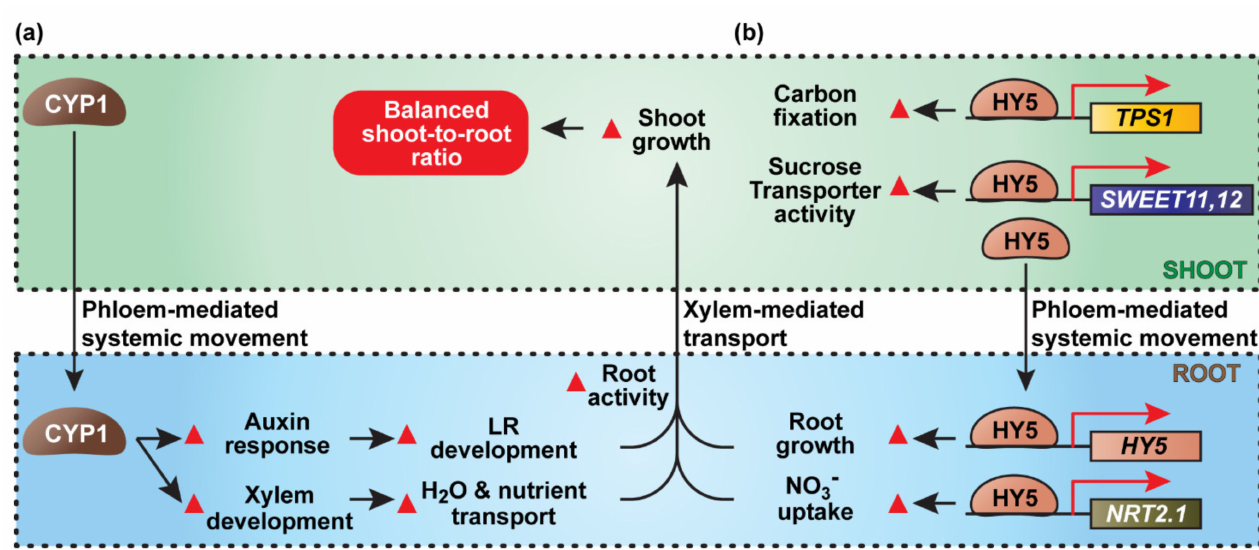
Figure 3. Light promotes root growth and nutrient absorption. ( a ) CYP1 is a phloem mobile protein that regulates shoot-to-root homeostasis. Light intensity determines the expression level of CYP1 in source leaves. Shoot-derived CYP1 protein accumulates in the roots, leading to activation of the auxin responses, thereby enhancing lateral root formation. Phloem-mediated systemic regulation, through this CYP1 pathway, is also involved in xylem development, which is critical for transport of H 2 O and mineral nutrients from roots to shoots. ( b ) Arabidopsis ELONGATED HYPOCOTYL5 (HY5), a key positive regulator of light signaling, is a phloem mobile transcription factor that traffics from shoot to root. In the aboveground tissue, HY5 binds to the promoters of TPS1, SWEET11, and SWEET12 to regulate carbon fixation and phloem-mediated transport of photoassimilates. Mobile HY5, derived from shoots, binds the promoter regions of HY5 and NRT2.1 genes in the root to promote root growth and nitrate uptake. Both shoot-derived CYP1 and HY5 can lead to enhanced root activity to improve shoot growth. These long-distance signaling agents also contribute to balancing the plant’s shoot-to-root ratio. Red darts indicate up-regulation of described